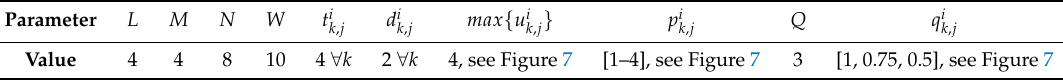
Figure 7. Energy provisioning and consumption profiles of the case study, and optimal energy allocation obtained with O PT T S NS. Parameters : According to Table 6. Table 6. Parameters of O PT T S NS and values regarding the case